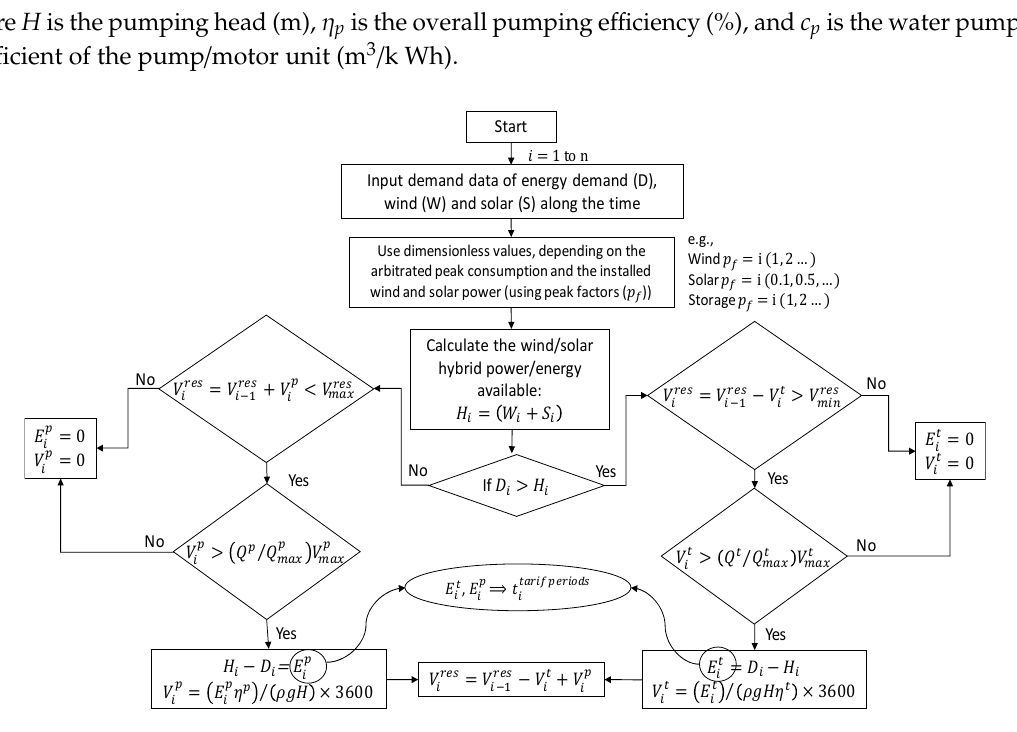
Figure 2. Flowchart to find optimal hybrid system. V is for water volume, E is for energy, D is the demand, H is for hybrid power / energy available, S is the solar energy and W is for wind energy. The superscripts ( p , t , res ) are assigned for pump, turbine and reservoir.